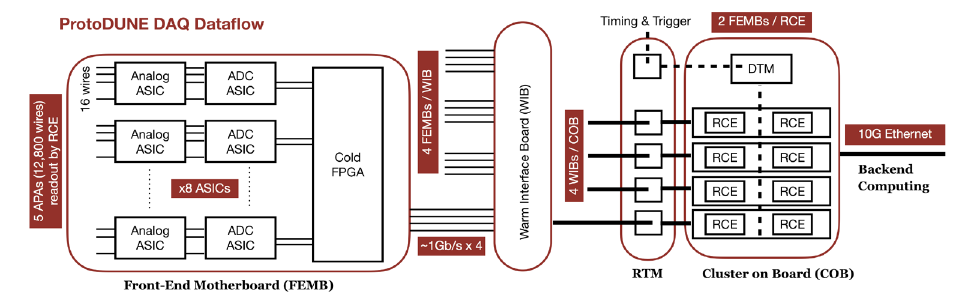
Figure 3. A block diagram of ProtoDUNE-SP